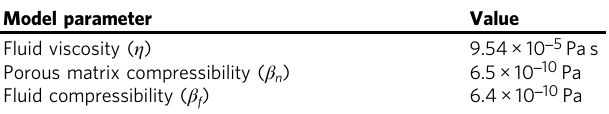
Table 1 Constant parameters assumed for all simulations presented in this work